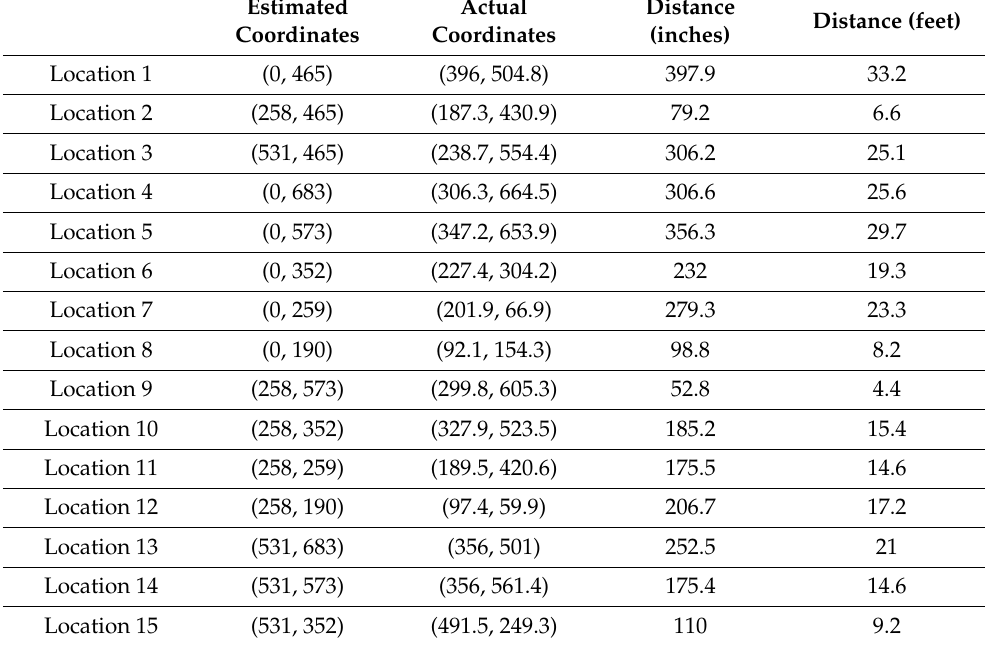
Table 2. Table containing distances from estimation to actual location.